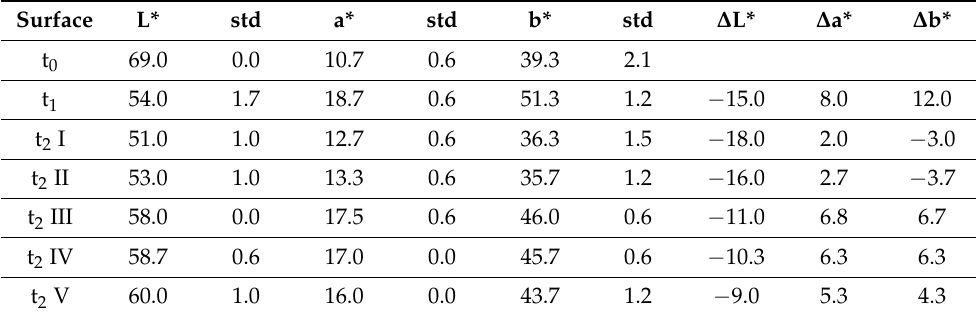
Figure 4. Yellow Ochre specimen as a function of laser treatment (I–V): ( a ) visible image; ( b ) UV-induced visible fluorescence; ( c ) bar plot of ∆ E(t2–t0) values. Each tested area I–V refers to 1 × 2 cm 2 area. Table 3 documents the colorimetric coordinates of the painted surface at t 0 , t 1 , t 2 . The data show that the shellac application (t 1 ) induced the diminishment of L* ( ∆ L t1–t0 = − 15.0) and a significant increase in both a* and b* parameters ( ∆ a t1–t0 * = 8.0 and ∆ b t1–t0 * = 12.0). Table 3. Colorimetric L*, a*, b* parameters and their standard deviations (std) of Yellow Ochre